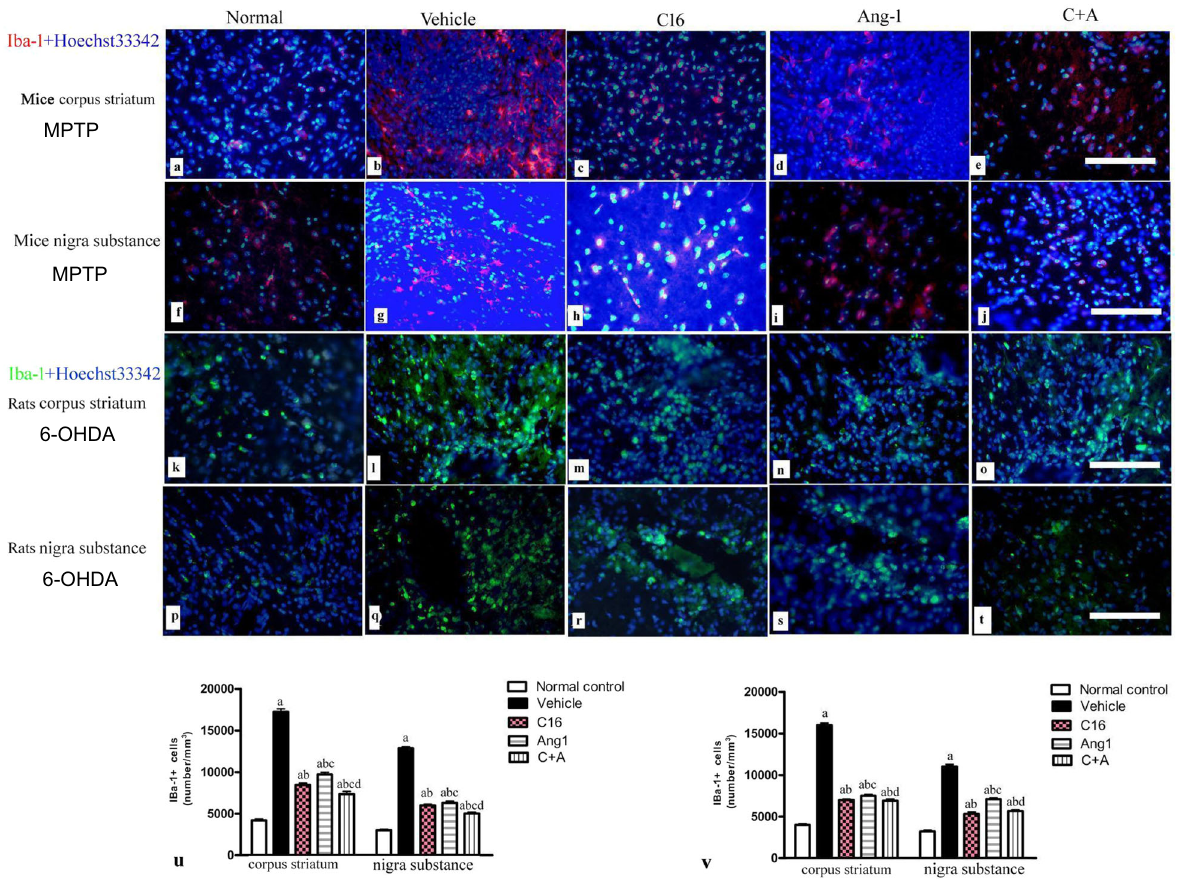
Fig. 10 C16 in combination with Ang-1 treatment supressed microglia activation. a – l The immunostaining of Iba-1 + cells (red in mice and green in rats) in the corpus striatum and nigra substance showed that C16 ( c , h , m , r ), Ang-1 ( d , i , n , s ), and especially the C16 plus Ang-1 treatment ( e , j , o , t ) suppressed the increase of microglia in PD models ( b , g , l , q ). Panel a , f , k , p show the normal control group. The nuclei of cells were labeled with Hoechst33342 (blue). Scale bar = 100 µm. ( u , v ): Stereological analysis of Iba-1 + cells in mice ( u ) and rats ( v ). ( a ), p < 0.05 versus the normal control group; ( b ), p < 0.05 versus the vehicle group ( c ), p < 0.05 versus the C16-treated group ( d ), p < 0.05 versus the Ang-1- treated group. Abbreviations: Iba-1, ionized calcium binding adapter molecule 1; C16, peptide (KAFDITYVRLKF) that can selectively bind integrin α ν β 3 ; Ang-1